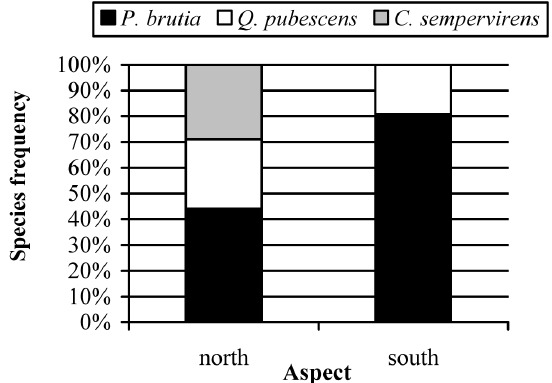
Figure 1. Species frequency in the mixed P. brutia stands on northern and southern aspects.